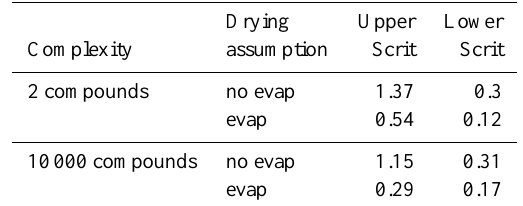
Table 3. Range of critical supersaturation (%) for an 100nm dry particle based on kappa values derived assuming: (no evap) no re-equilibration of organic semi-volatiles on drying and (evap) re- equilibration of all organic semi-volatiles on drying. Upper and lower limits taken from difference between N-N/vp act and N-JR predictive techniques listed in table